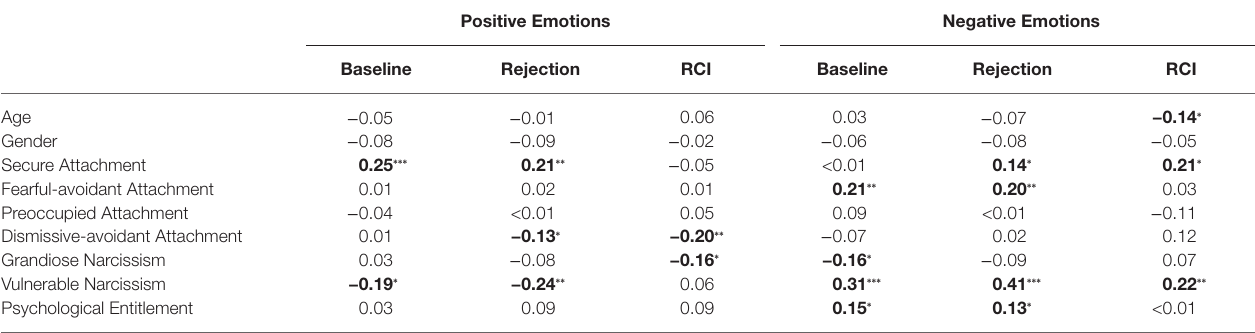
TABLE 3 | Regression analyses predicting positive and negative affect after each condition and change in affect in response to